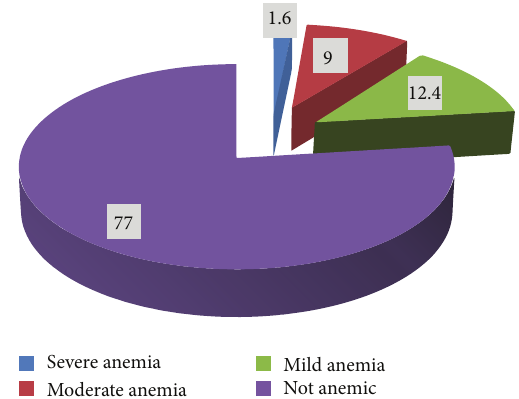
Figure 1: Prevalence and severity of anemia among pregnant mothers in Ethiopia, EDHS